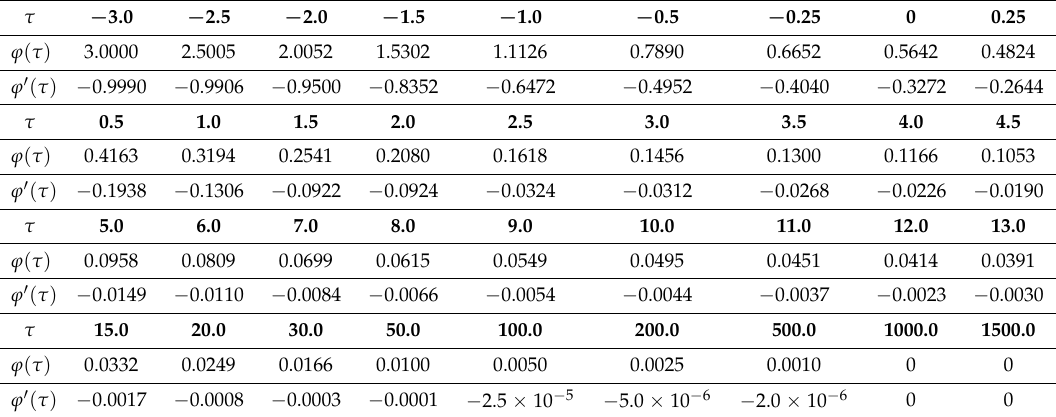
Table 1. The governing function ϕ ( τ ) of the effective time τ .